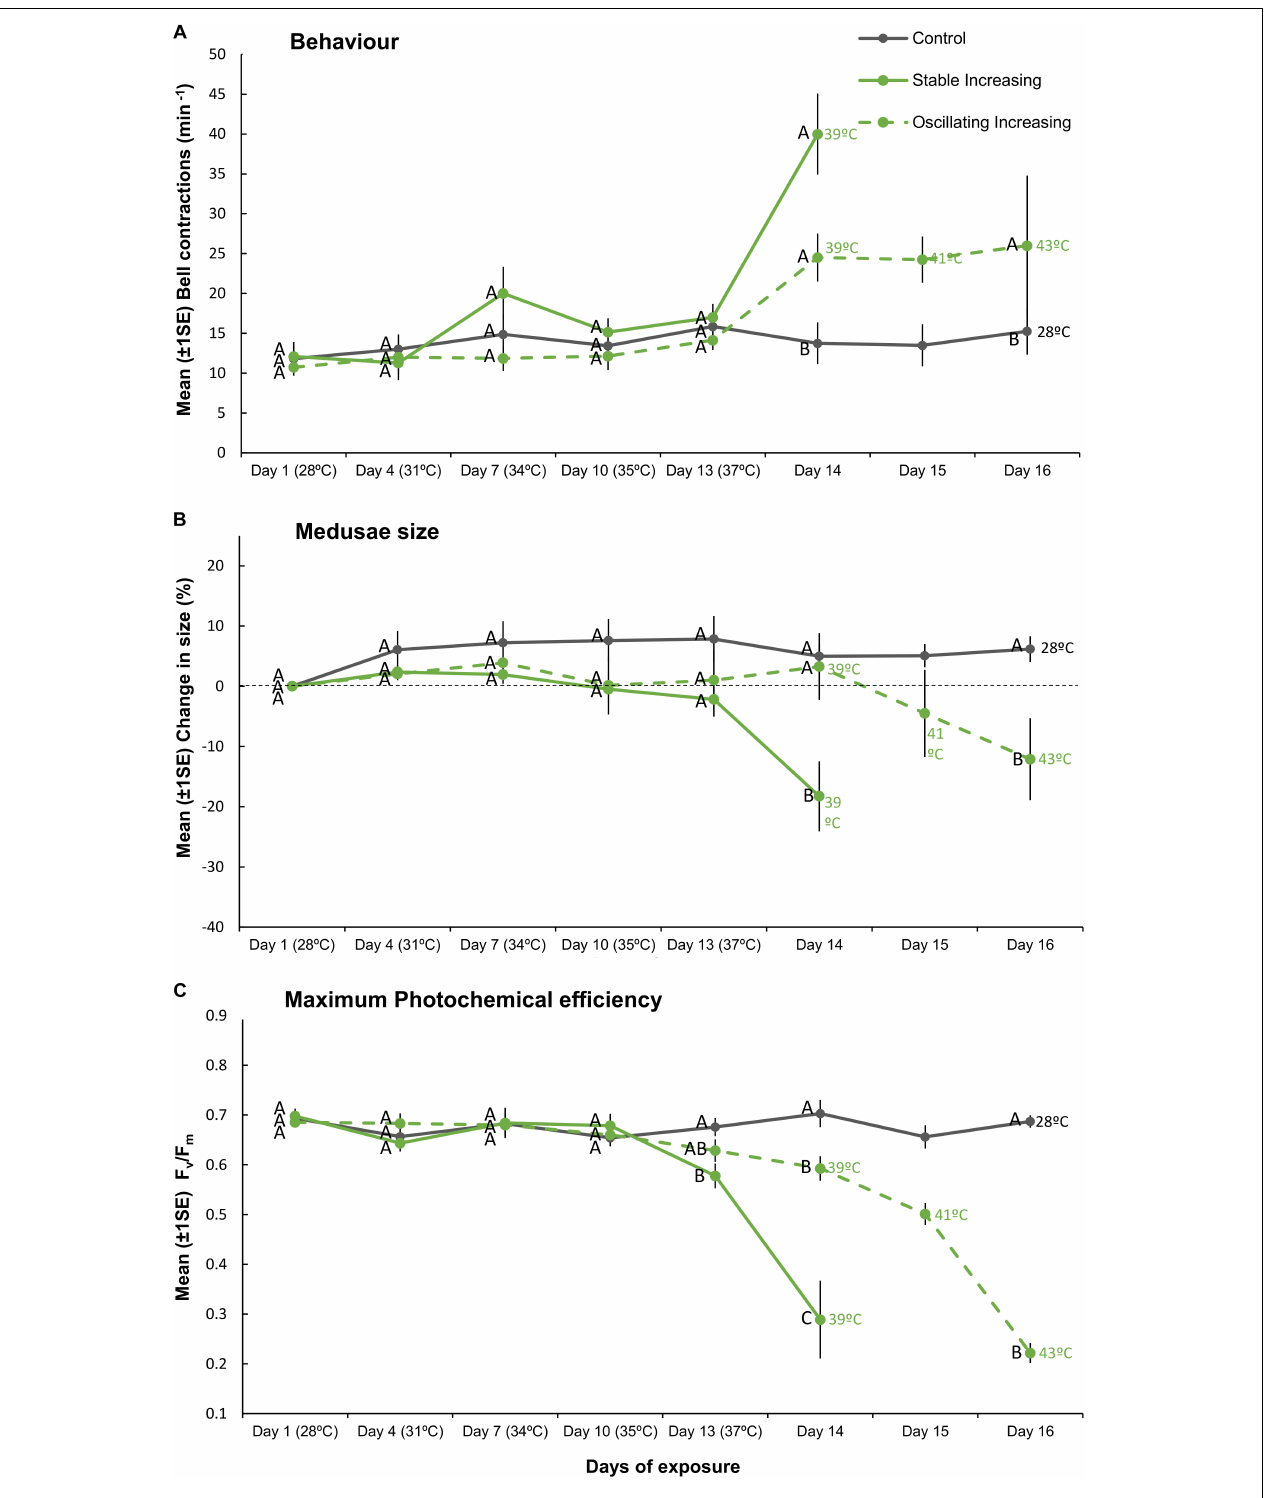
FIGURE 4 | Mean ( ± 1SE) (A) bell contractions (number min − 1 ), (B) change in size of medusae (%), and (C) maximum photochemical efficiency (F v /F m ), recorded throughout the 16-day exposure period for each treatment (S Incr , O Incr , and Control) employed in “Increasing” experiment (Part III). Letters next to data points indicate similarities (e.g., AA) or differences (e.g., AB) between the three treatments at each time point, as determined by estimated marginal means post hoc analyses, resulting from analyses reported in Supplementary Tables S6 , S7 . Note; sample sizes vary through time [Day 1 ( n = 11), Days 4–13 ( n = 7), Day 14 ( n = 4), Days 15–16 ( n = 3) ( n represents number of replicates per treatment)].